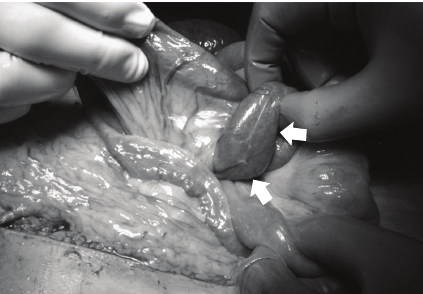
Figure 1: Abdominal computed tomography before surgery. Com- puted tomography demonstrated internal hernia of the small intes- tine (arrow: small intestine through the hernia orifice).